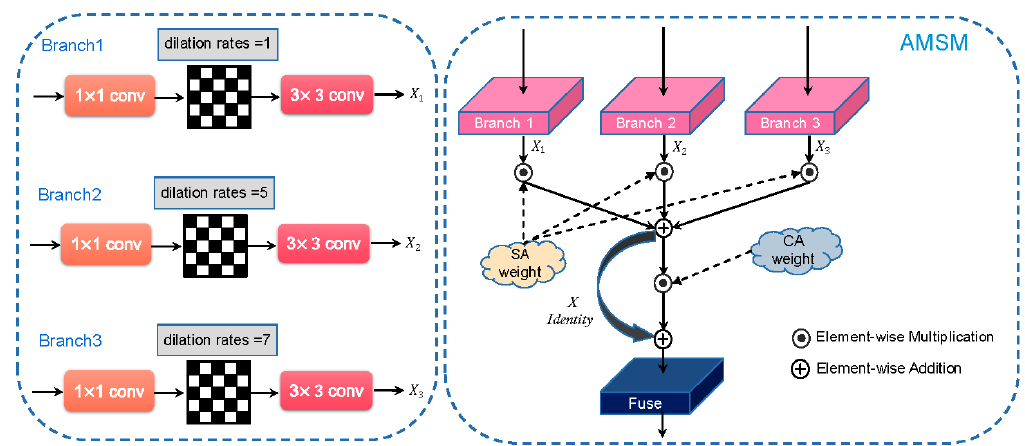
Figure 4. AMSM architecture diagram. The left part is the specific structure and various parameters of the three branches, and the right part is the topology image of an Adaptive Multi-Scale Module (AMSM).